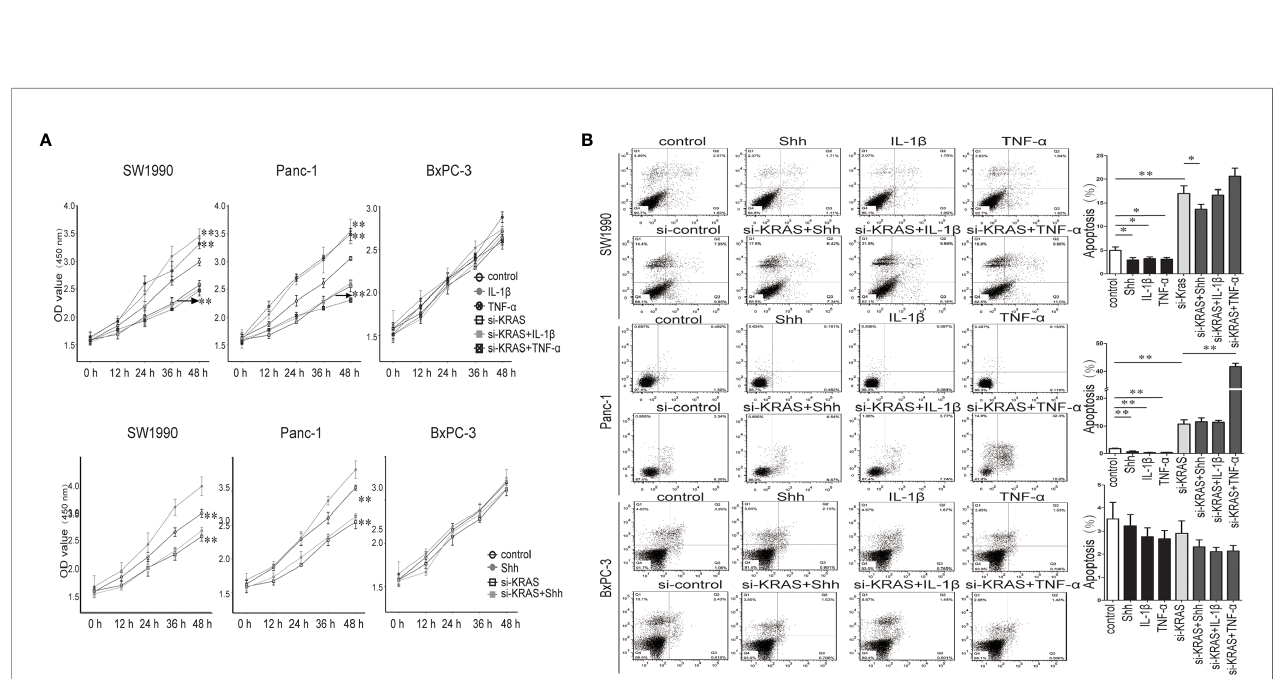
FIGURE 6 | The proliferation and apoptosis effect on PDAC cell lines and PDAC tumor growth in a nude mouse xenograft tumor model treated IL-1 b , TNF- a or Shh, in combination with si-KRAS transfection. (A) The effect on cell proliferation; (B) The effect on the apoptosis. *p < 0.05; **p <